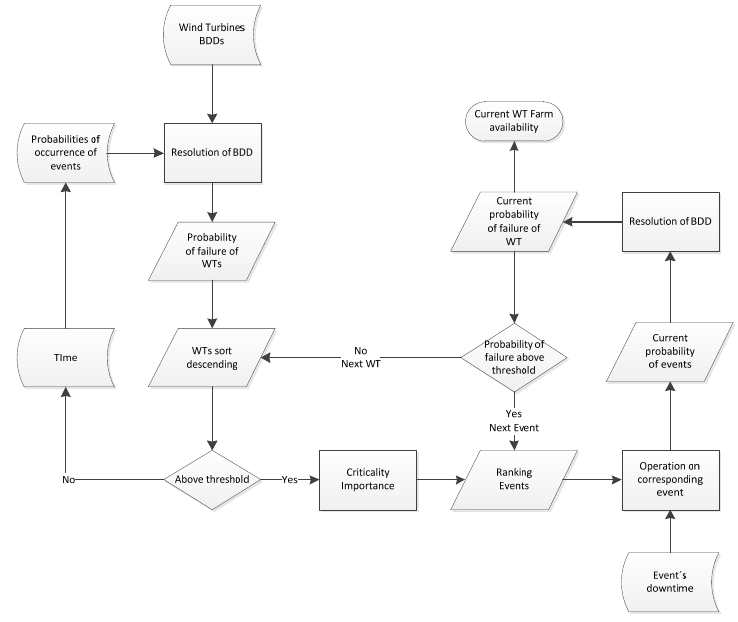
Figure 3. The maintenance management procedure.